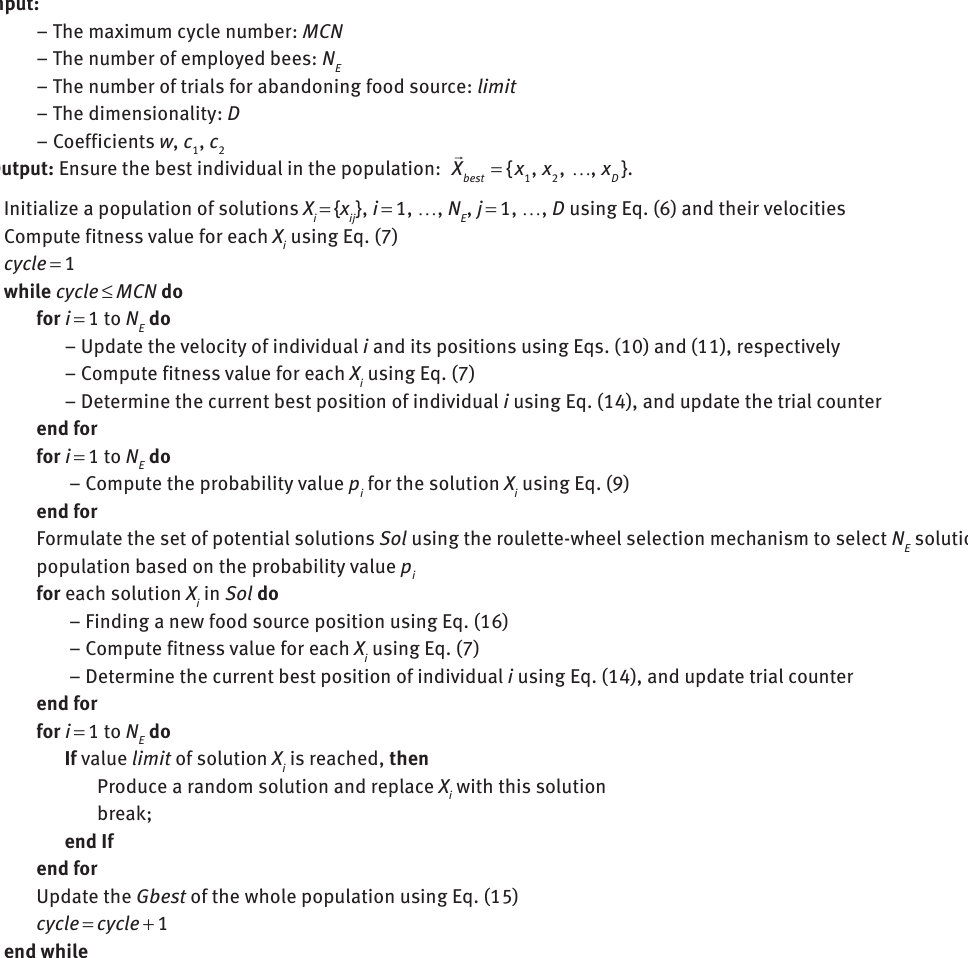
Algorithm 3: The Pseudo Code of the ABC-PSO